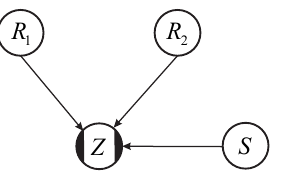
Figure 8. BN representing the limit state function Z = R 1 + R 2 − S for one cross section.